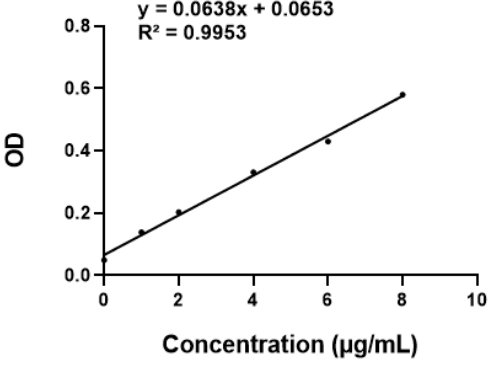
Figure 2. Standard curve of AST.